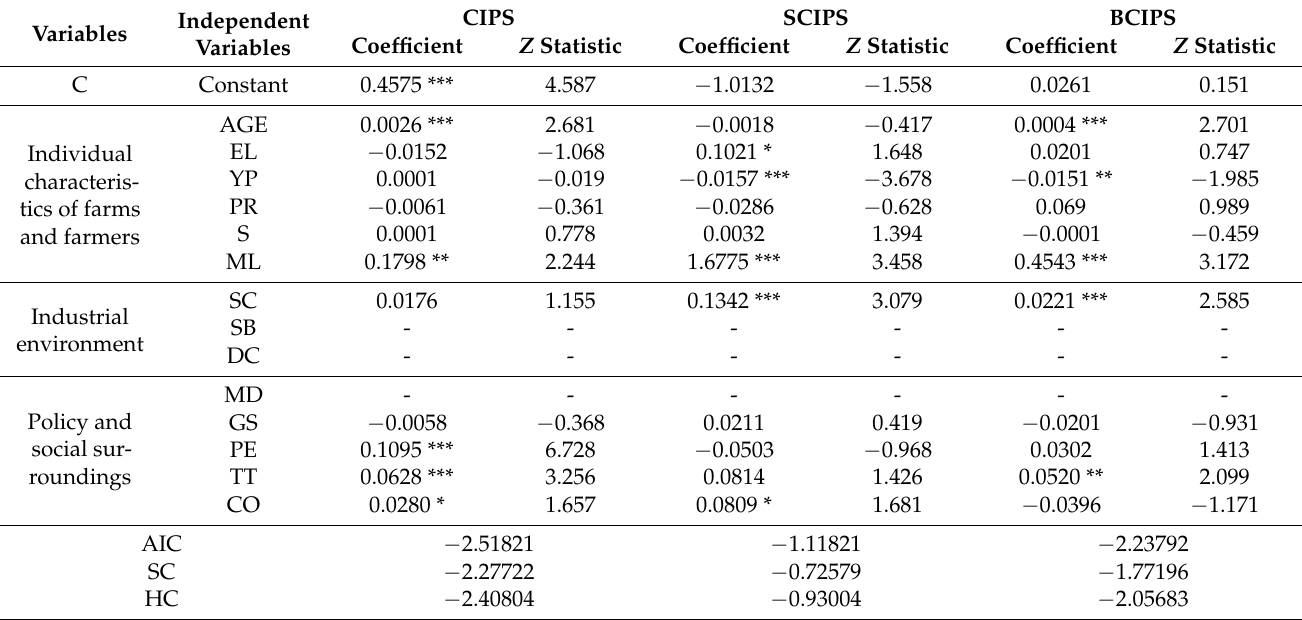
Table A4. Test Results (2) of the Data Fit Analysis of the Tobit